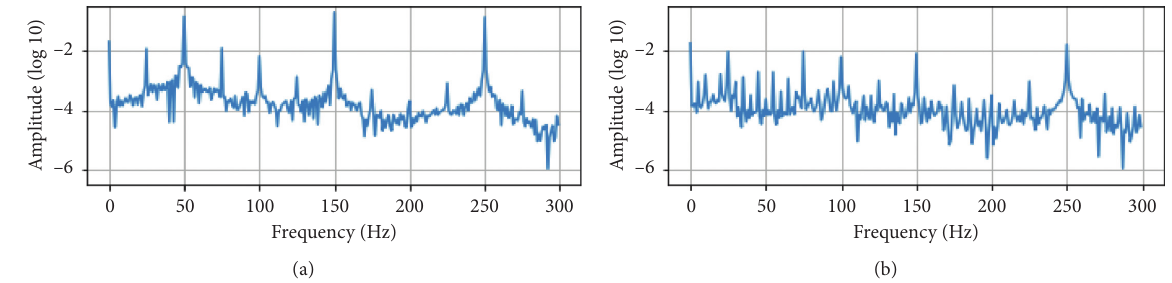
Figure 7: Comparison of amplitude spectrum after the usage of WPD and SSA. (a) WPD result. (b) SSA